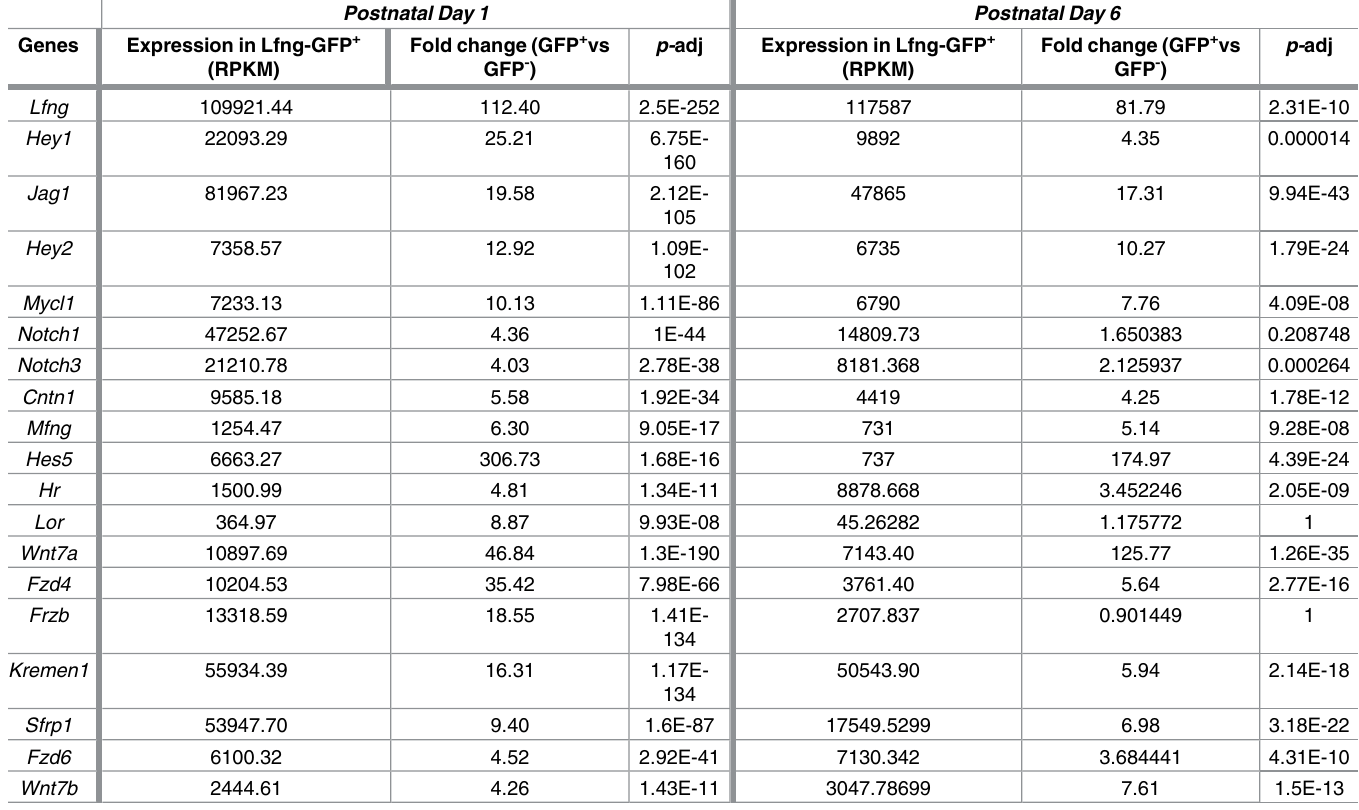
Table 8. Notch and Wnt pathway genes expressed in Lfng-GFP + cells at P1 and